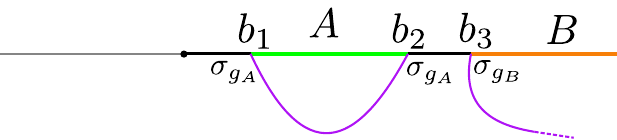
Figure 5. OPE channel corresponding to phase-III of the reflected entropy for two disjoint intervals.